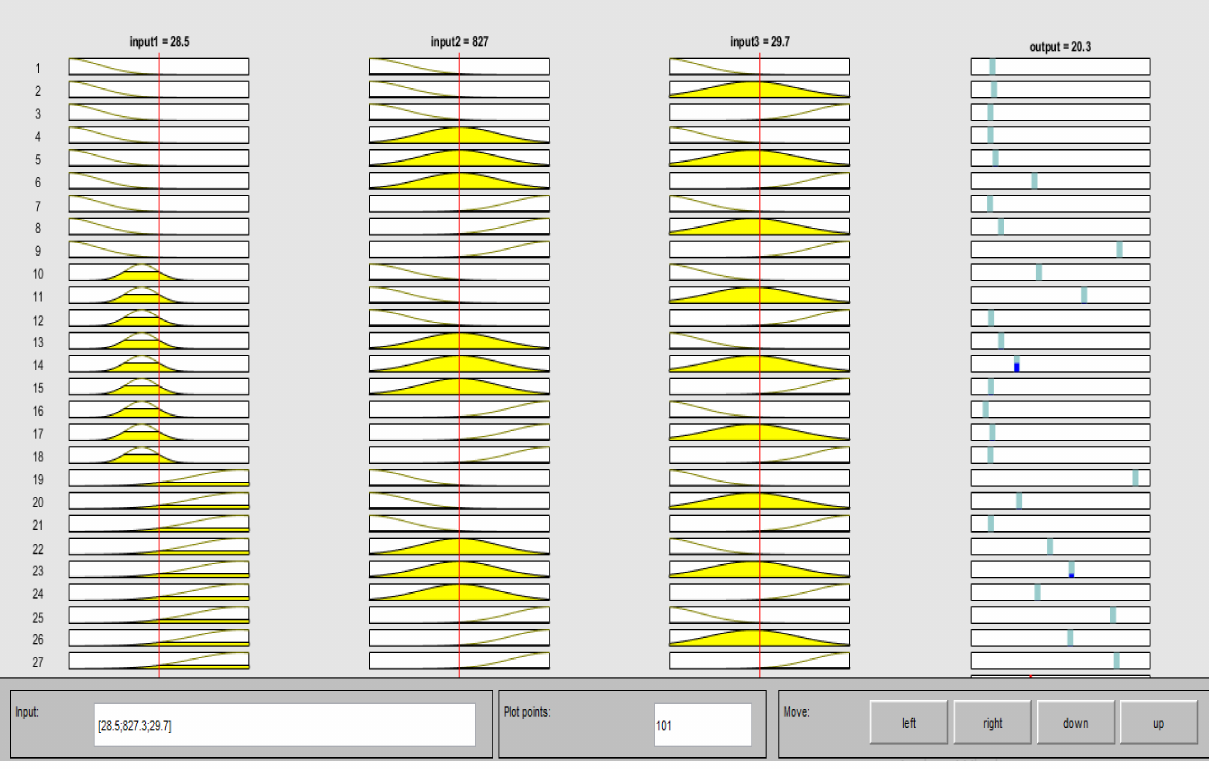
Figure 19. Rules